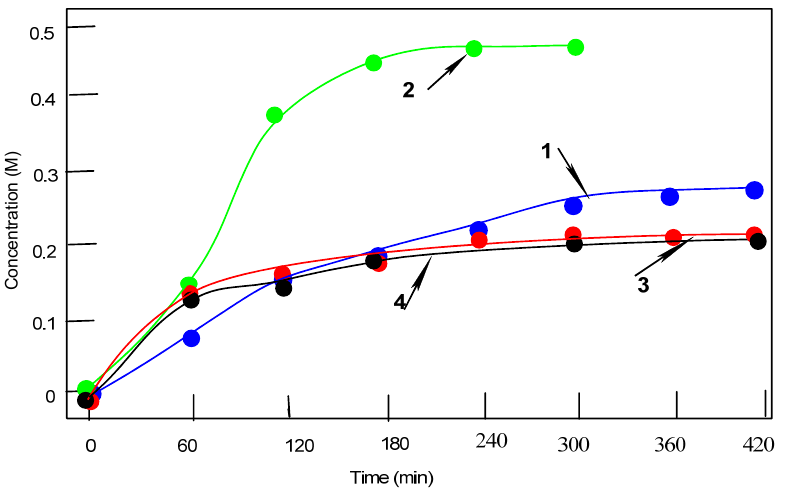
Figure 7. Accumulation of cyclohexanone (yield = 40%, TON = 400) in oxidation of cyclohexanol (0.5 M; 0.14 mL in 2.5 mL total volume; blue—curve 1), acetophenone (yield = 90%, TON = 900) in oxidation of phenylethanol (0.5 M; 0.16 mL in 2.5 mL total volume; green—curve 2), 2-heptanone (yield = 40%, TON = 400) in oxidation of 2-heptanol (0.5 M; 0.14 mL in 2.5 mL total volume red—curve 3) and 2-hexanone(yield = 40%, TON = 400) in oxidation of 2-hexanol (0.5 M; 0.16 mL in 2.5 mL total volume; black—curve 4) with tert -butyl hydroperoxide (1.5 M; 0.36 mL 70% aqueous in 2.5 mL total volume) catalyzed by compound 3 (5 × 10 − 4 M; 3 mg) in the absence of HNO 3 in MeCN at 50 °C.